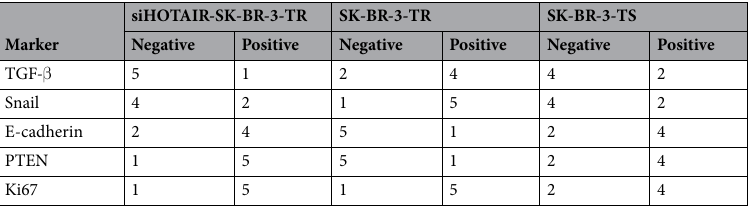
Table 2. Positive rates of relevant proteins in tumor tissues derived from different cell lines (n =